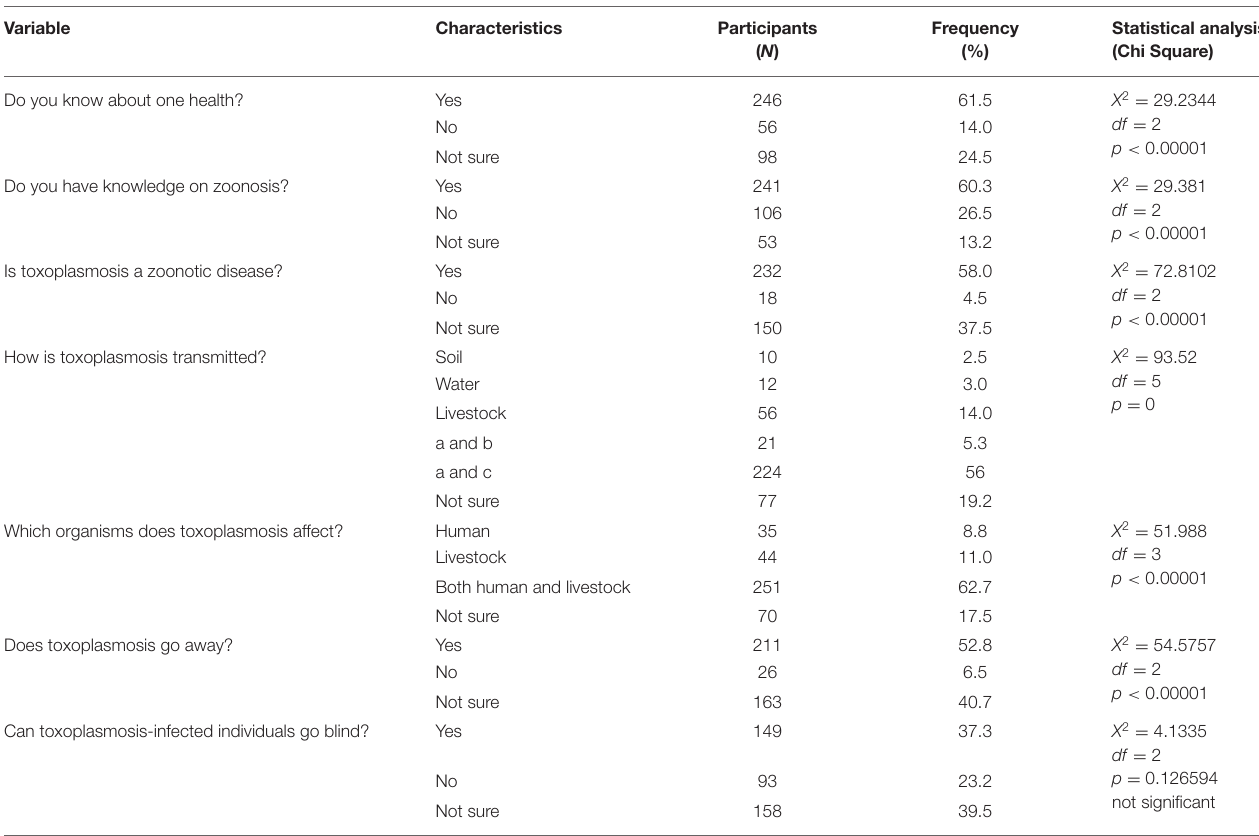
TABLE 6 | One health knowledge about toxoplasmosis among participants. Variable